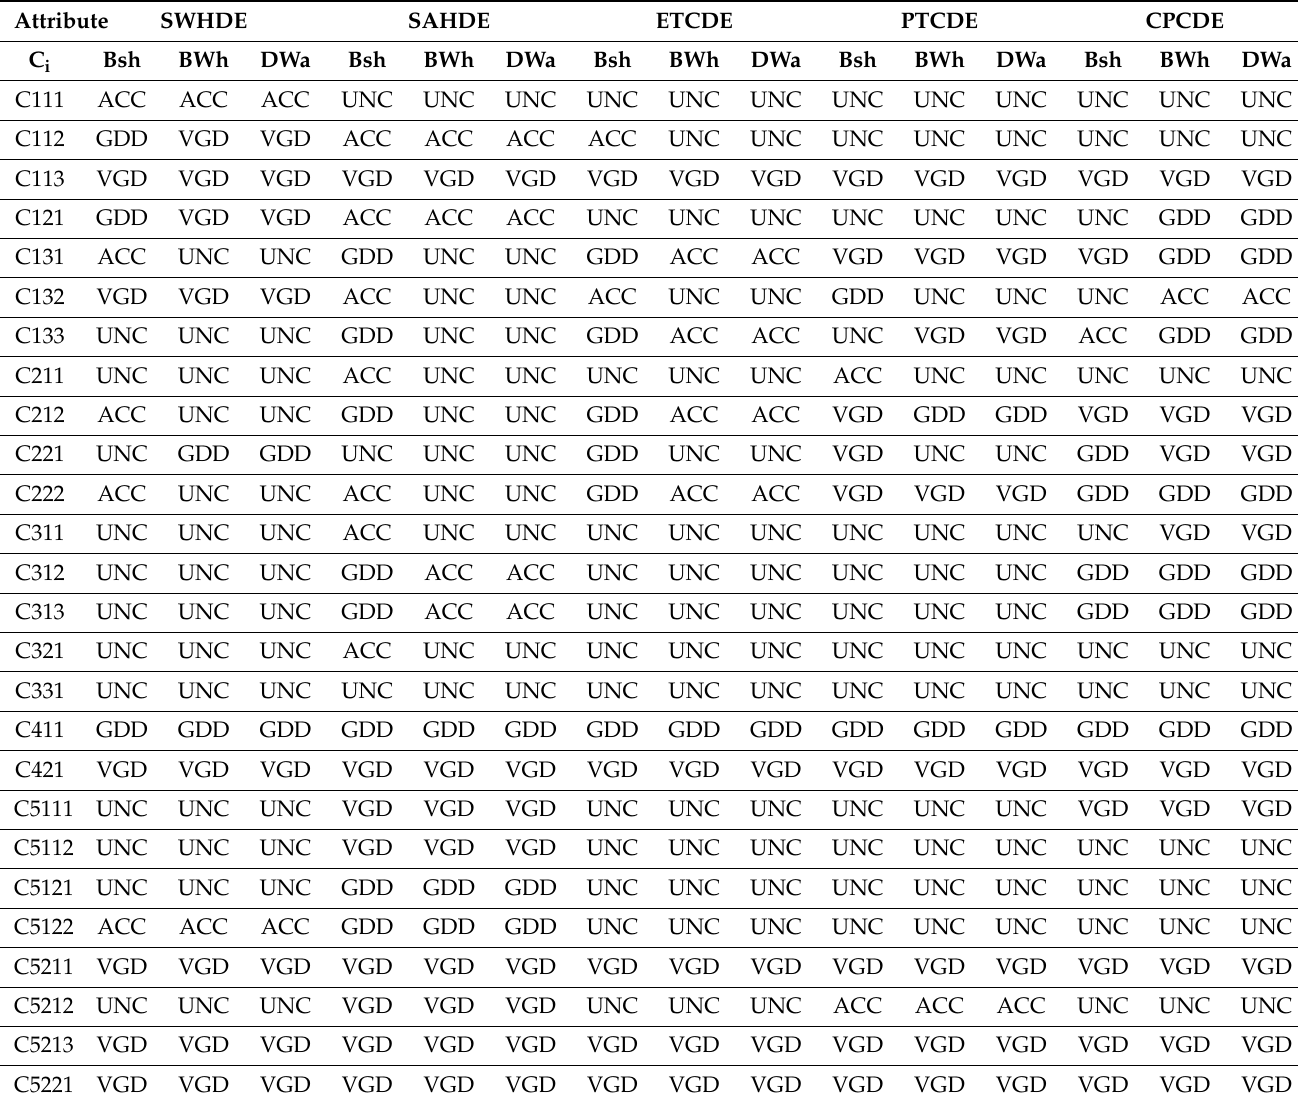
Table 9. Ranking of basic attributes for Niger (Bsh), Riyadh (BWh) and Beijing (DWA) climate zone for double effect